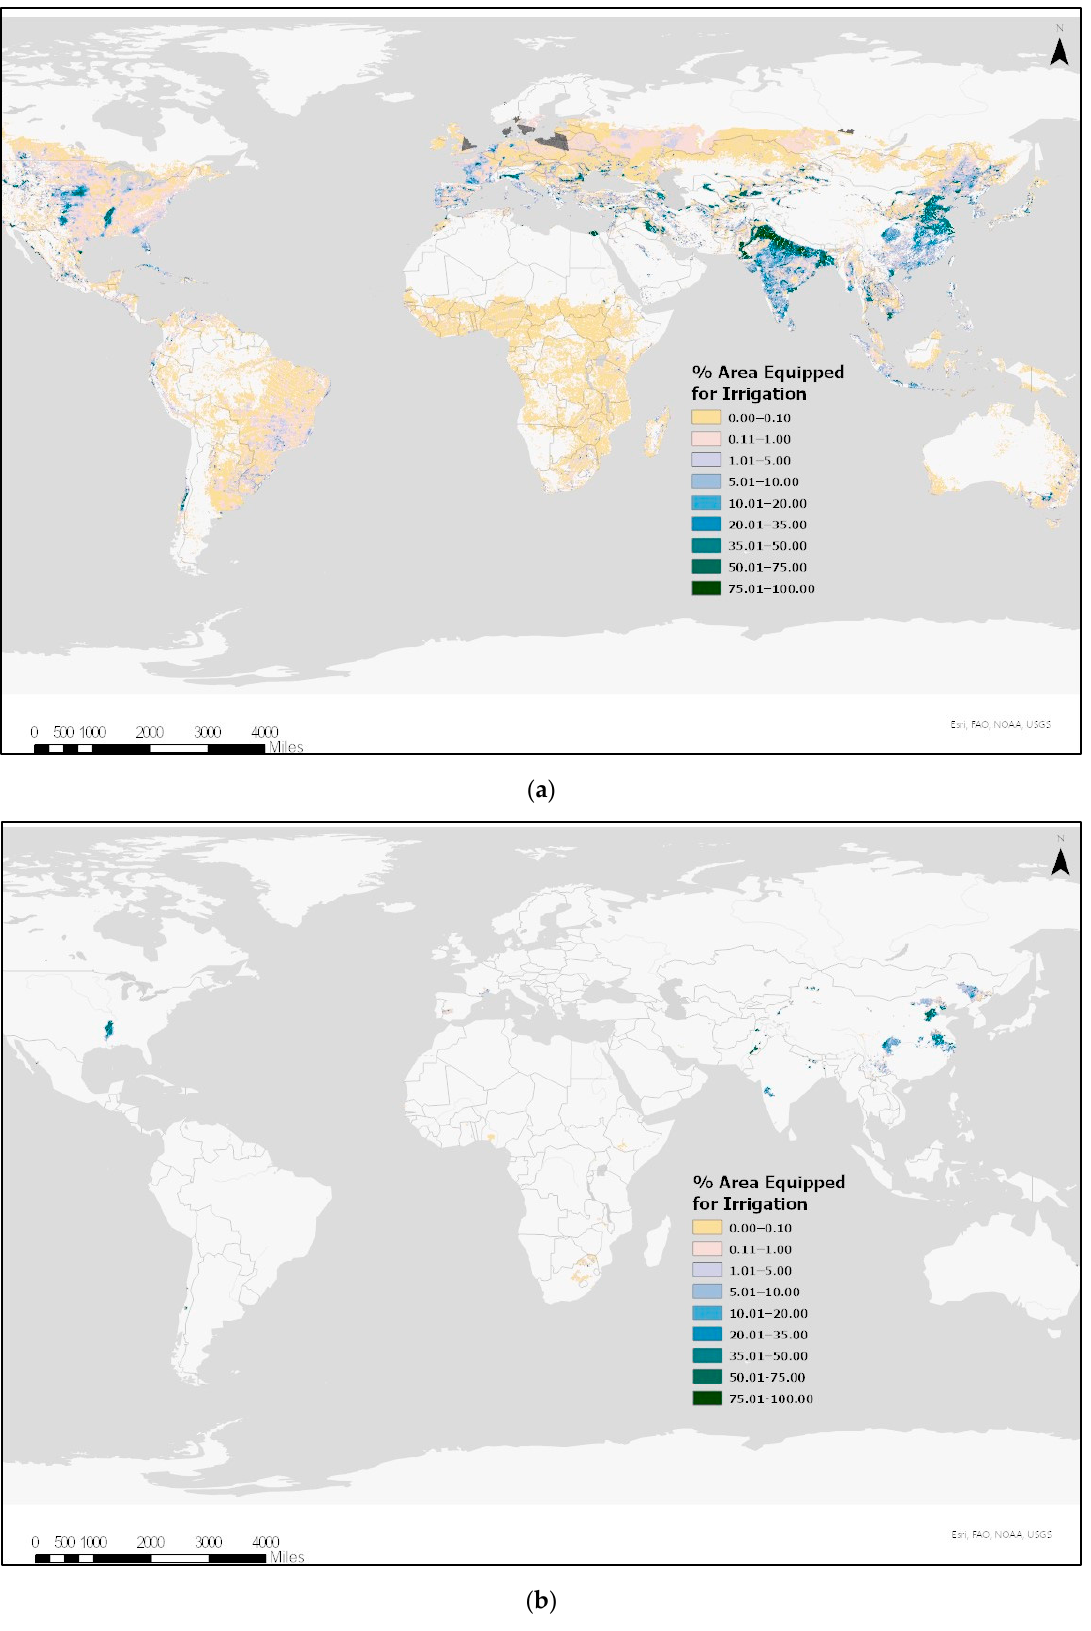
Figure 3. ( a ) Global extent for % Area Equipped for Irrigation variable. ( b ) Sample extent for % Area Equipped for Irrigation variable.